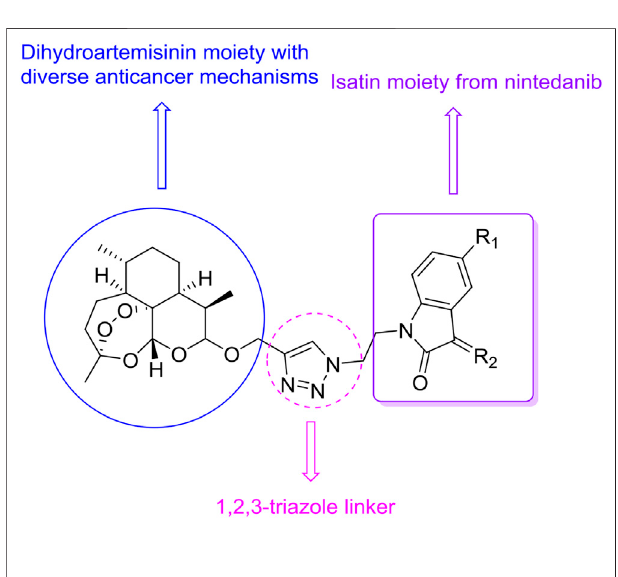
FIGURE 2 | Chemical structures of 1,2,3-triazole tethered dihydroartemisinin-isatin